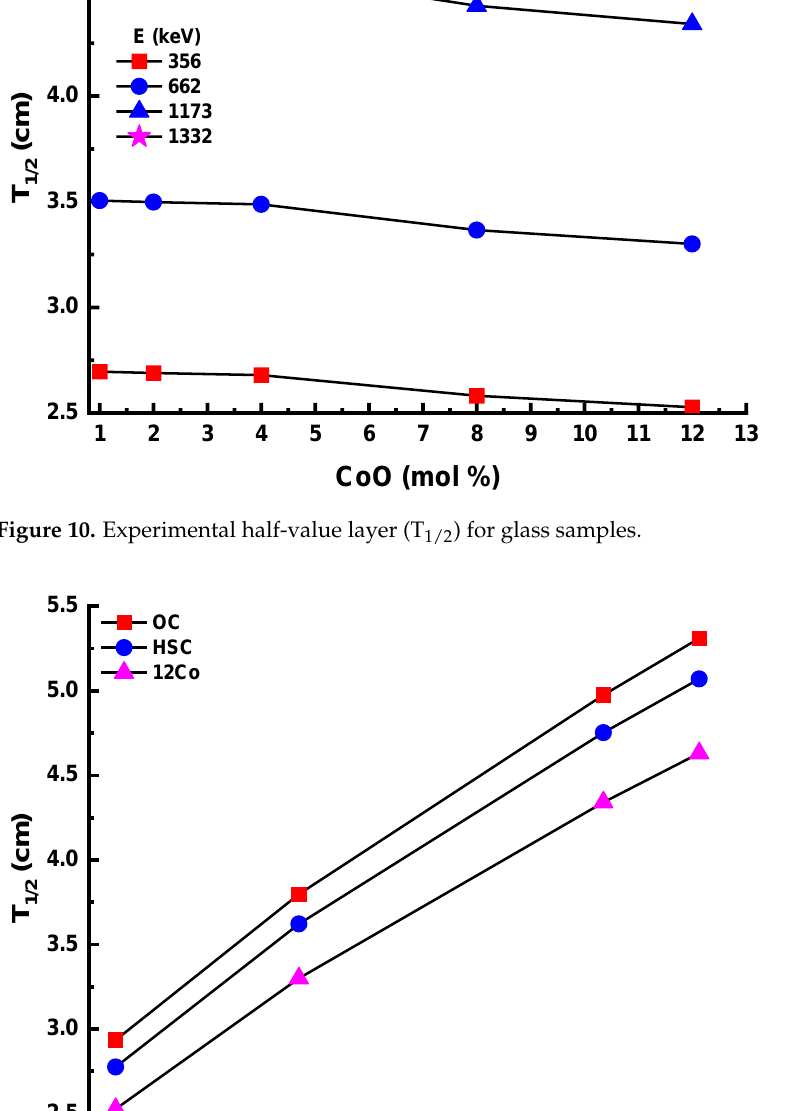
Figure 11. Comparison of experimental half-value layer (T 1/2 ) value of the 12Co sample with both ordinary concrete (OC) and hematite-serpentine concrete (HSC) [31].